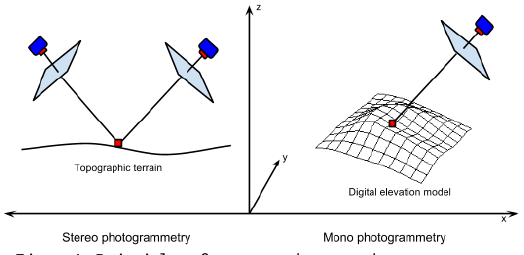
Figure 1. Principles of stereo and mono photogrammetry